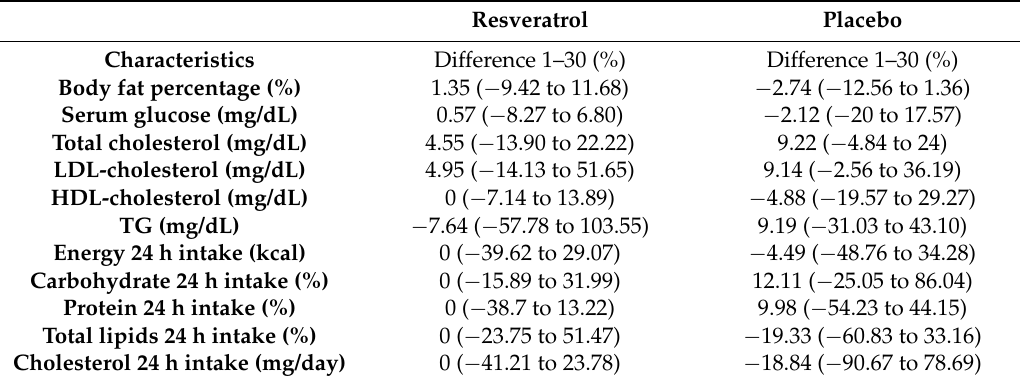
Table 3. Characteristics of subjects with schizophrenia on the percentage variation of 4 weeks of resveratrol supplementation or placebo.